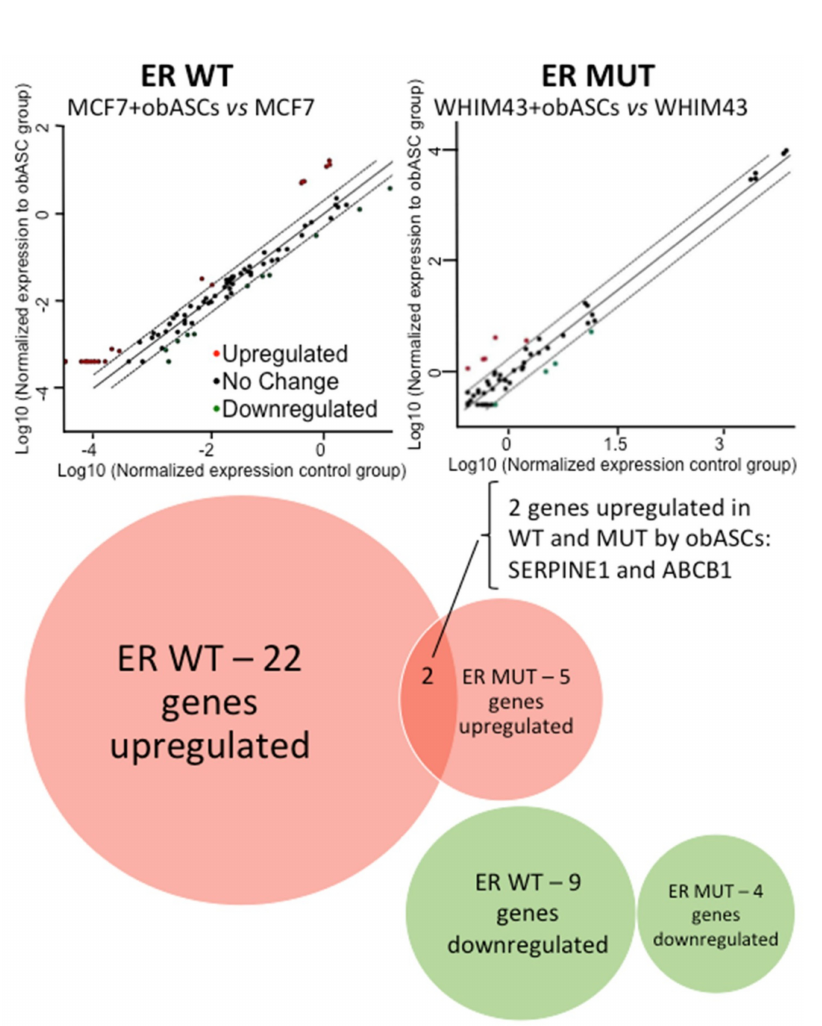
Figure 3. PCR array demonstrates that obASCs upregulate two common genes in ER WT and ER MUT cells. PCR array demonstrates that obASCs upregulate above a cutoff of 2x: 22 BC related genes in ER WT (MCF7) cells compared to 5 genes ER MUT (WHIM43) and downregulated 9 BC related genes in ER WT compared to 4 in ER MUT. Two genes were upregulated in both ER WT and ER MUT: SERPINE1 and ABCB1. PCR arrays were conducted ( n = 1) for each